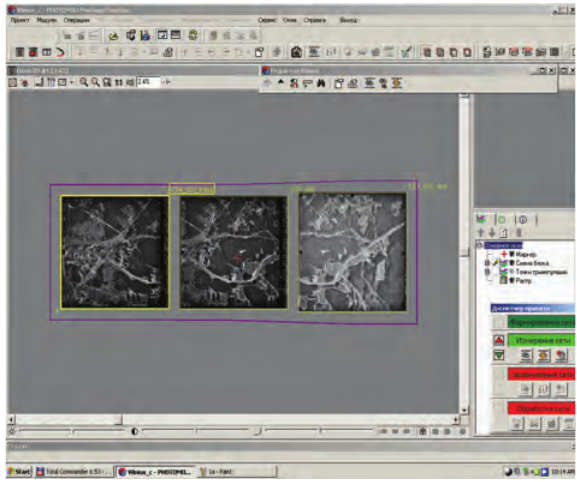
Fig. 1 . Experimental photogrammetric block used in PHOTOMOD